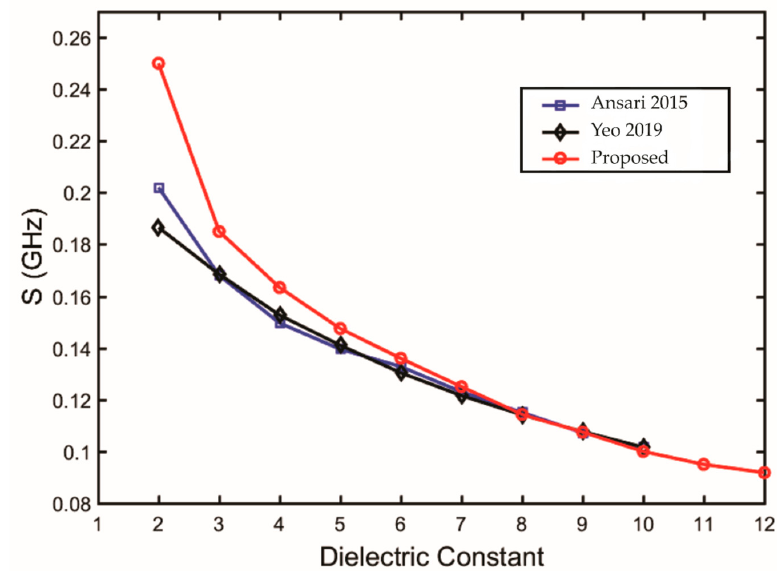
Figure 9. Results of the sensitivity parameter of the proposed sensor.